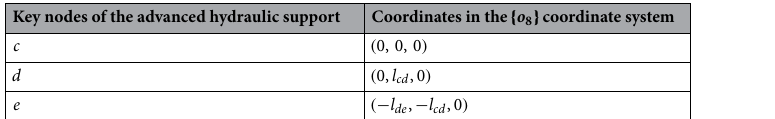
Key nodes of the advanced hydraulic support